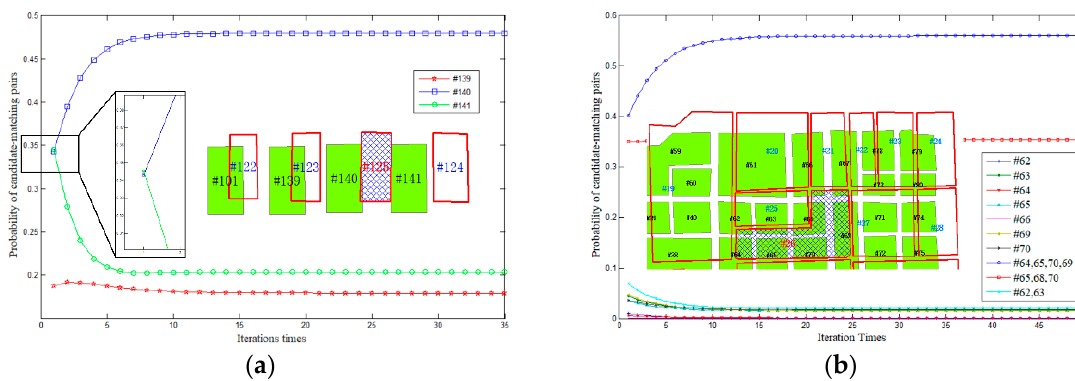
Figure 9. Matching probability change during the relaxation labelling process: ( a ) probability change of candidate-matching pairs of object #125; ( b ) probability change of candidate-matching pairs of object #26.